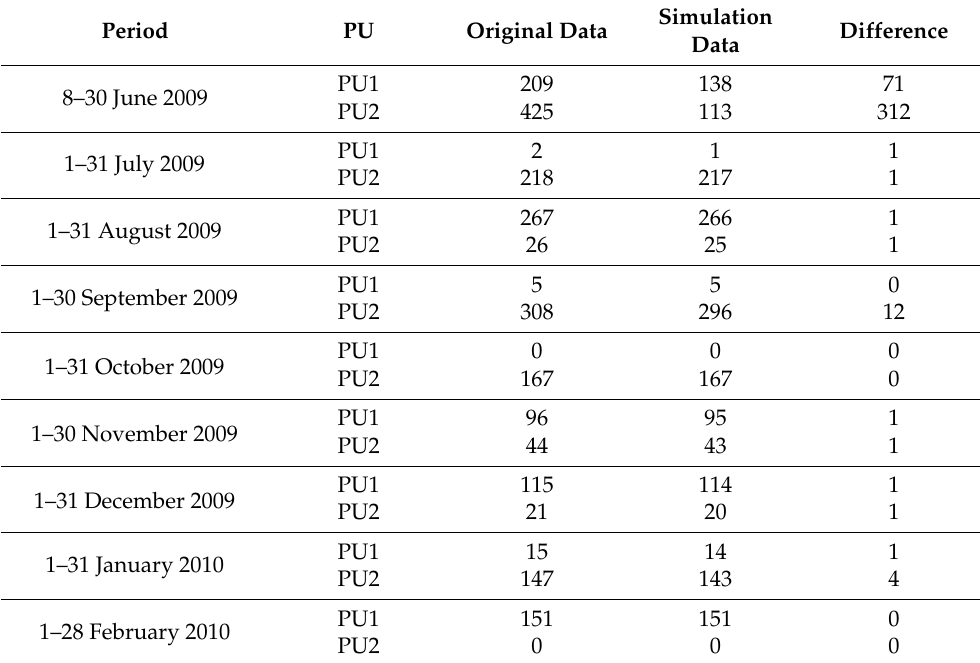
Table 1. The overview of the total number of switching off cycles and AR. Period PU Original Data